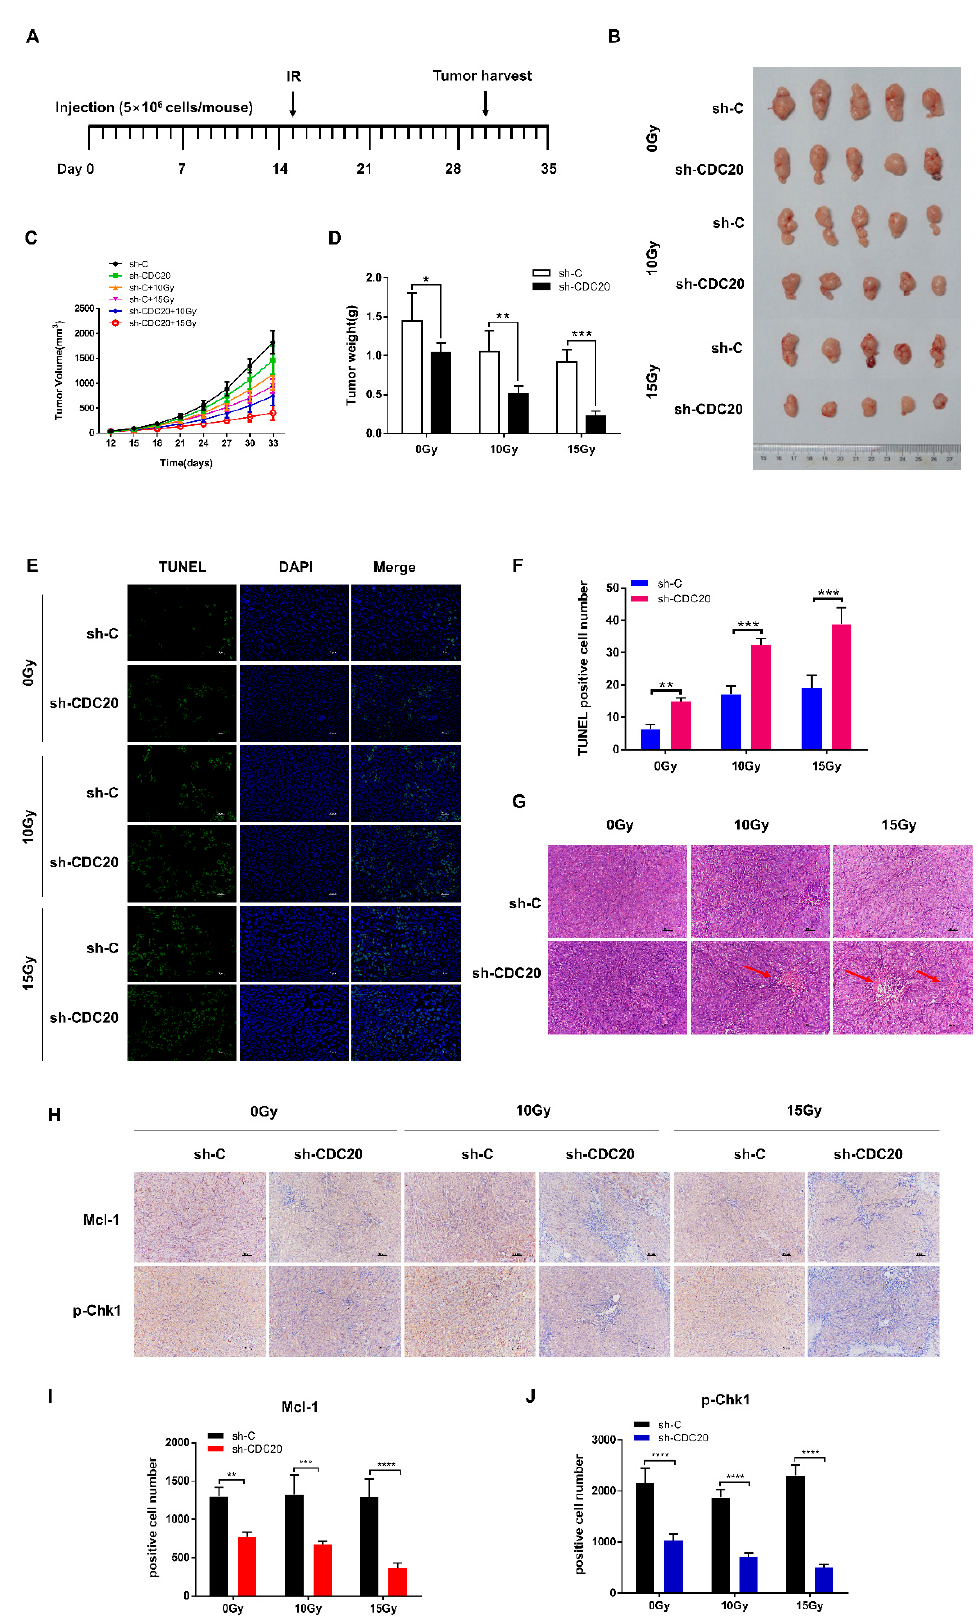
Figure 5. CDC20 knockdown suppresses the tumor formation of colorectal cancer (CRC) through inducing apoptosis in vivo. ( A ) Plan of animal experiments. ( B ) Tumor xenografts of each group are shown. Each group of mice was composed of five BALB/c-nu/nu mice. HCT116 control vector cells (sh-C, 5 × 10 6 ) and CDC20 knockdown HCT116 cells (sh-CDC20, 5 × 10 6 ) were inoculated under the dorsal skin of BALB/c-nu/nu mice. After 15 days of injection, mice were irradiated with 0 Gy, 10 Gy or 15 Gy gamma-rays. On the 33rd day after injection, the mice were sacrificed, and tumors were obtained. ( C , D ) The tumor volume ( C ) and net weights ( D ) of each group are shown. Tumor size was measured with dull-edged vernier calipers every 3 days, calculated as follows: volume = (length × width 2 )/2. The weight of the tumor was determined when the mice were sacrificed. ( E ) Apoptotic cells in tumor sections were identified by Terminal dexynucleotidyl Transferase (TdT)-mediated dUTP nick end labeling (TUNEL) assay. Representative images of tumor sections from sh-C and sh-CDC20 mice under different doses of gamma-ray treatment are shown. The scale bar represents 25 µm. ( F ) The number of apoptotic cells shown in ( E ) was quantified using GraphPad Prism. (G) Necrotic cells in tumor sections were identified by Hematoxylin-Eosin (H&E) staining. Representative images of tumor sections from sh-C and sh-CDC20 mice under different doses of gamma-ray treatment are shown. The scale bar represents 50 µm. ( H ) Immunohistochemical analysis of Mcl-1 and p-Chk1 expression in the tumor xenografts. Representative immunohistochemical staining of both Mcl-1 and p-Chk1 from sh-C and sh-CDC20 mice under different doses of gamma-ray treatment are shown (magnification, × 200). The scale bar represents 50 µm. ( I , J ) The number of positive cells shown in ( H ) was quantified using GraphPad Prism. Data were pooled from three independent experiments and the results are represented as mean ± SD; * p < 0.05, ** p < 0.01, *** p < 0.001, **** p < 0.0001. 3. Discussion The role of CDC20 as an oncogene has been increasingly recognized and widely reported in a variety of human cancers [33,34]. TCGA transcriptome data indicate that CDC20 is highly expressed in human cancers (Figure S1, Supplementary Materials). CDC20 is mainly involved in regulating the cell cycle and plays an oncogenic role in human tumorigenesis [7]. CDC20 mediates the resistance to docetaxel in castration-resistant prostate cancer in a Bim-dependent manner [33]. Targeting CDC20 is a better cancer therapeutic strategy, because knocking down CDC20 can lead to mitotic arrest and cell death, and can effectively kill apoptosis-resistant cancer cells [34]. In this study, we found that radiation upregulated the expression of CDC20, and CDC20 increased the proliferation and radiation-induced DNA damage repair and inhibited intrinsic apoptosis of CRC cells (Figures 1C–F and 2). Using the immunodeficient athymic nude mice, we further observed that inhibiting CDC20 activities increased the sensitivity of CRC cells to radiation by inducing apoptosis in tumors (Figure 5E–G). Collectively, our data suggested that CDC20 significantly inhibited the radiosensitivity of CRC both in vitro and in vivo.